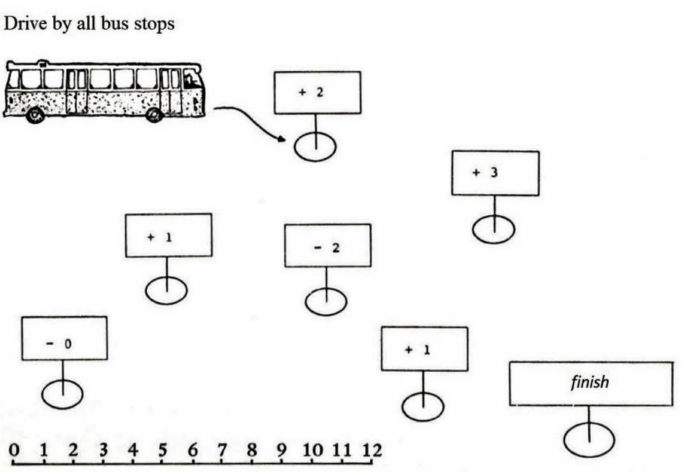
Figure 1. The bus context in Wiskobas. [39] (p. 41).